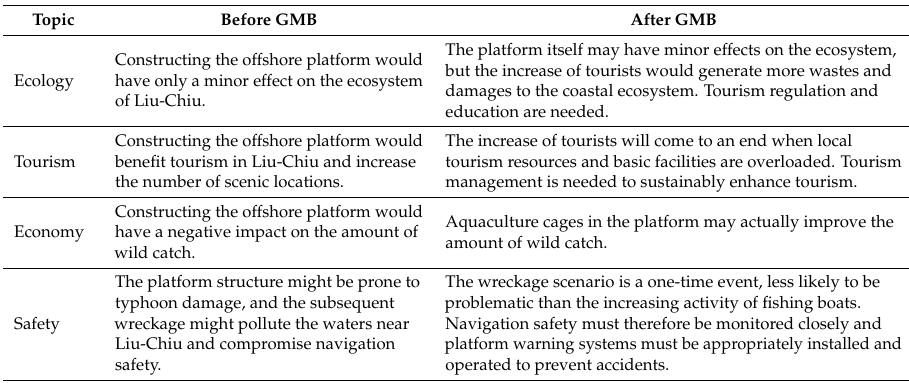
Table 4. Comparison of the stakeholders’ opinions before and after